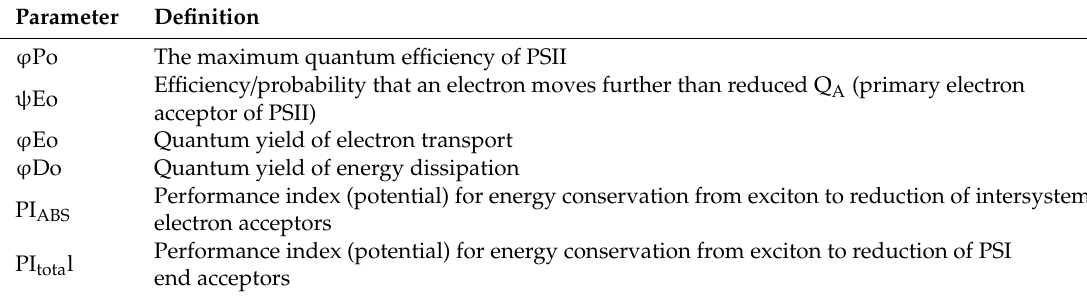
Table2. DefinitionsoftermsforcalculationoftheJIP-testparametersfromthechlorophyll, afluorescence transient OJIP emitted by dark-adapted leaves.